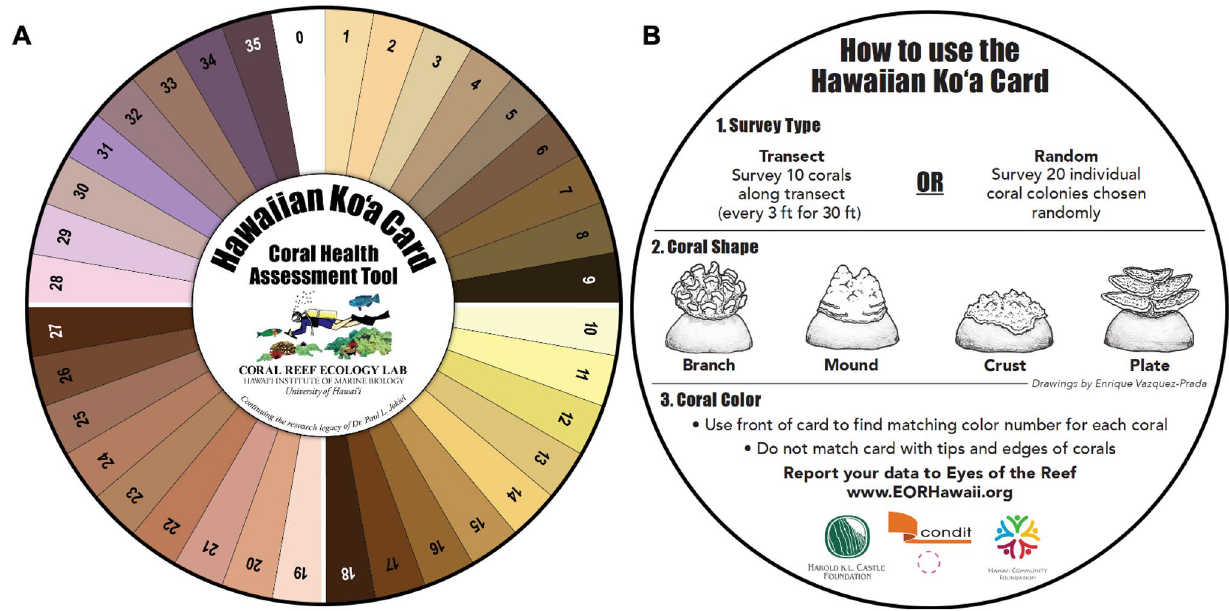
Fig. 2 The Hawaiian Ko ʻ a Card Coral Health Assessment Tool front ( A ) and back ( B ) Figure not to scale (card diameter = 18.5